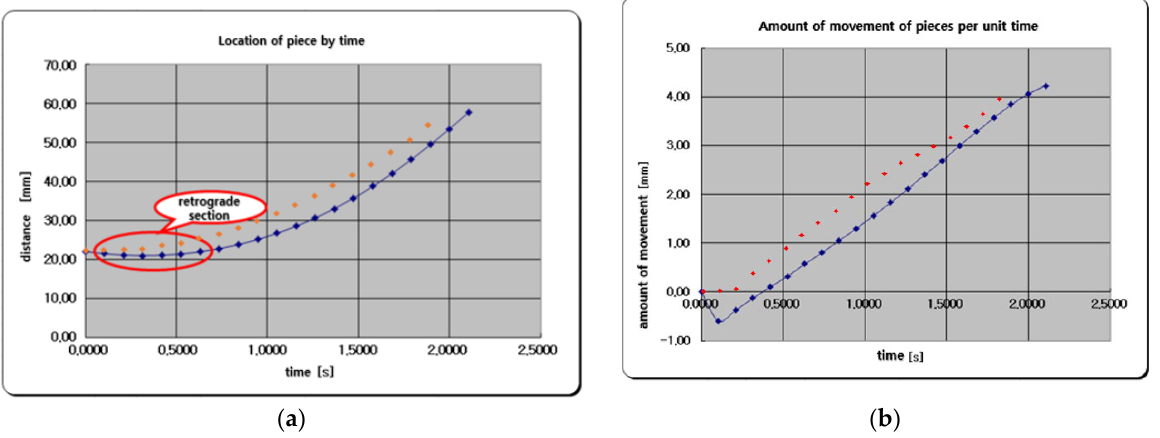
Figure 10. When the normal (orange) and spline (blue) curve of the slide plate rail was 30 degrees at a constant speed: ( a ) Location of piece over time; ( b ) Amount of movement of pieces per unit time.